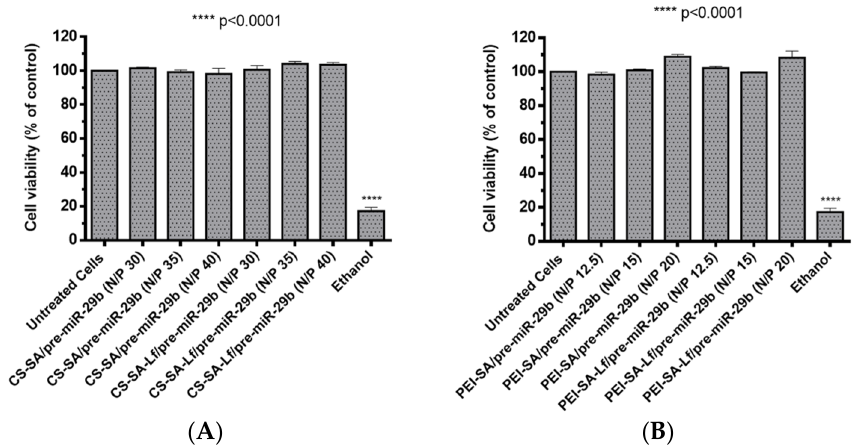
Figure 5. Relative cell viability of RBE4 cells treated with different pre-miR-29b-loaded polyplexes at various N/P ratios for 24 h: ( A ) CS-based polyplexes and ( B ) PEI-based polyplexes.